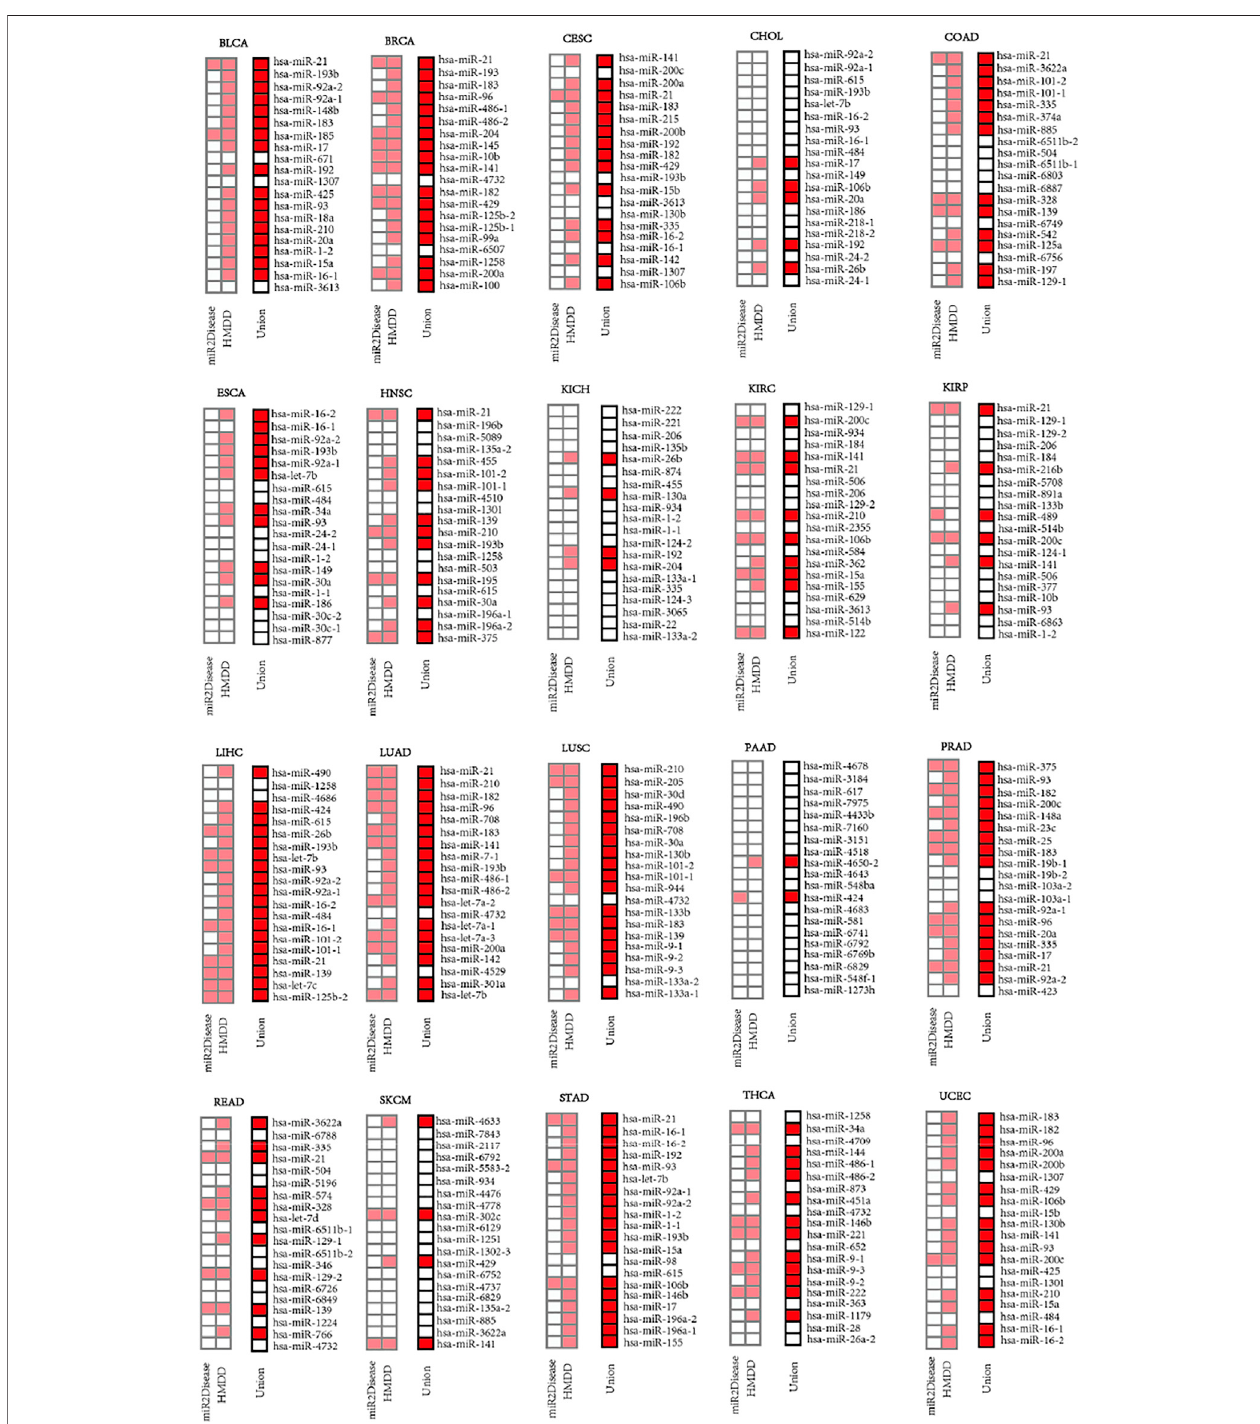
FIGURE 4 | Top-20 ranked miRNAs on the lists of priorities (squares in light red or red color) for 20 types of cancer when searched against the miR2Disease and HMDD databases, respectively.